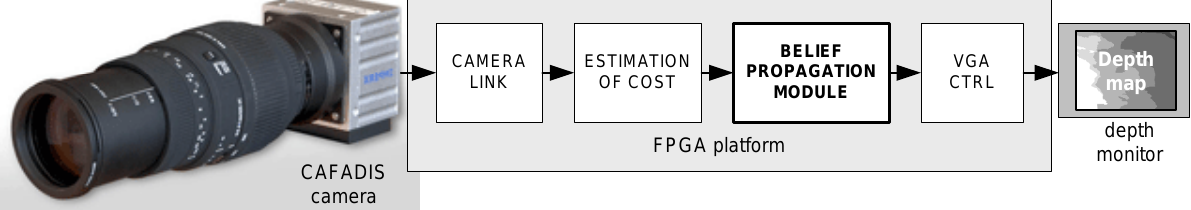
Figure 1. Overall system to be integrated in a portable video camera.